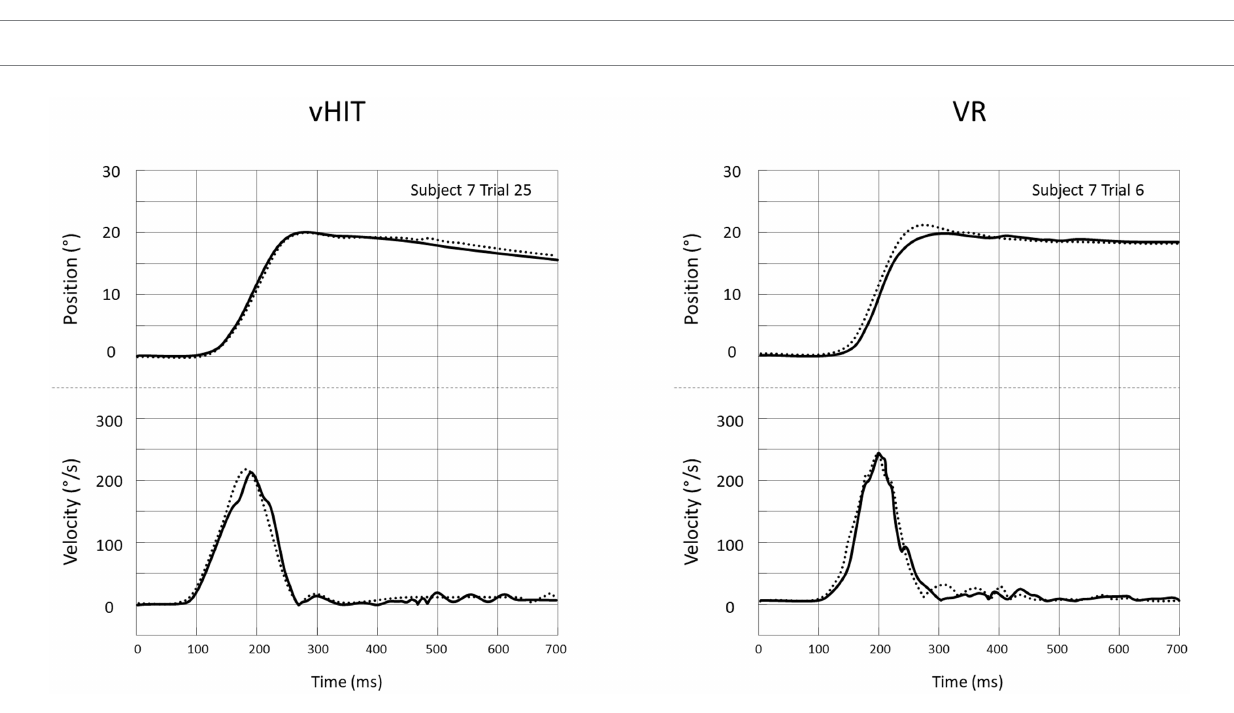
FIGURE 3 Comparison of three head measurement systems: example of eye and head movements during a single head impulse test in the rightward direction. Eye position is measured by the SMI system (inverted in the plot by convention: grey line). Head position (black lines) is measured simultaneously by the Native Vive system (dotted line …… ) and the Vicon system using markers fixed on the cap (dashed line _ _ _ ) and and on the HMD (dash-dotted line _ . _ . _ ). The black rectangle highlights the artefact occurring with the native Vive system.